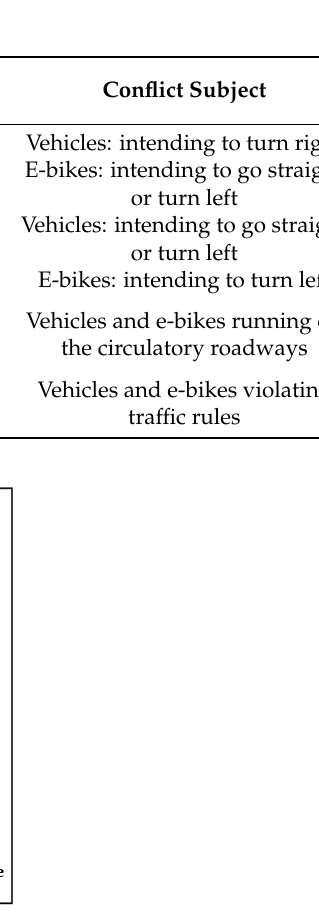
Figure 10. Conflict times and ratios of 4 conflict types.